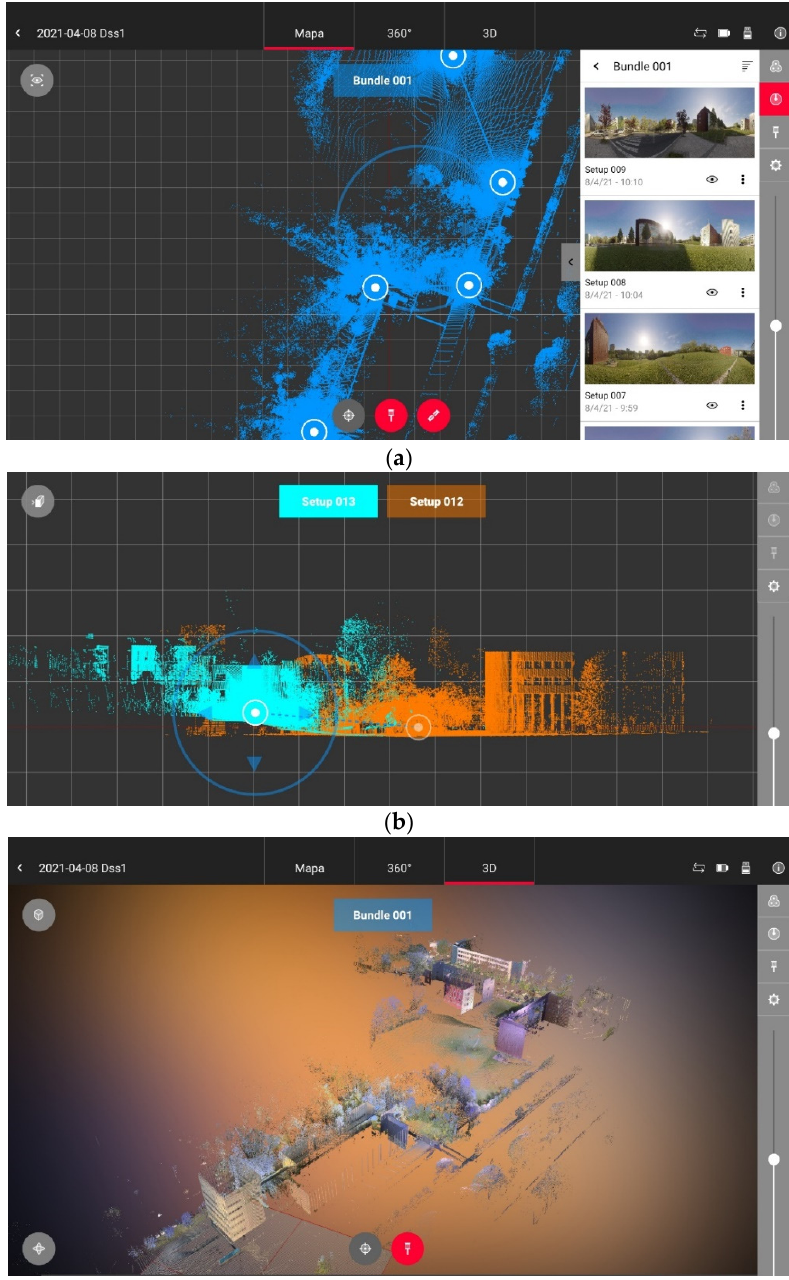
Figure 7. Cloud pre-processing with the Leica Cylone Field 360. DSS Campus, Zone 3: ( a ) union of the clouds in plan and 360° panoramic images; ( b ) inion in “cloud-to-cloud” section between two clouds; ( c ) 3D cloud join preview.